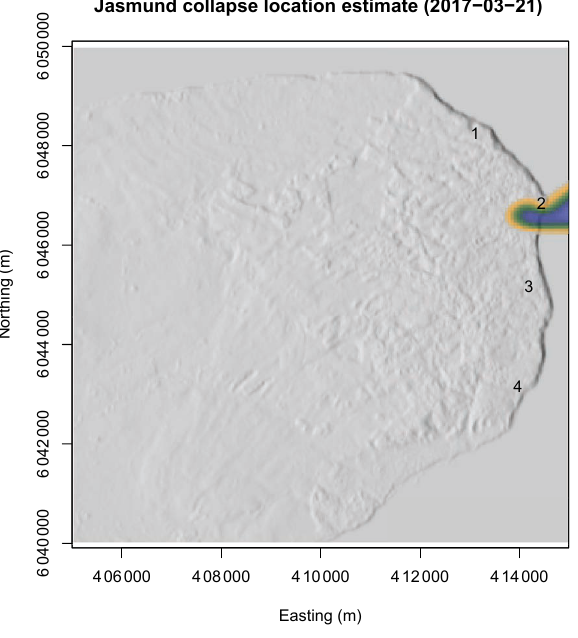
Figure 7. Seismic location estimate of the cliff collapse event de- picted in Fig. 5 as a semi-transparent hill shade map overlay with seismic station locations indicated by